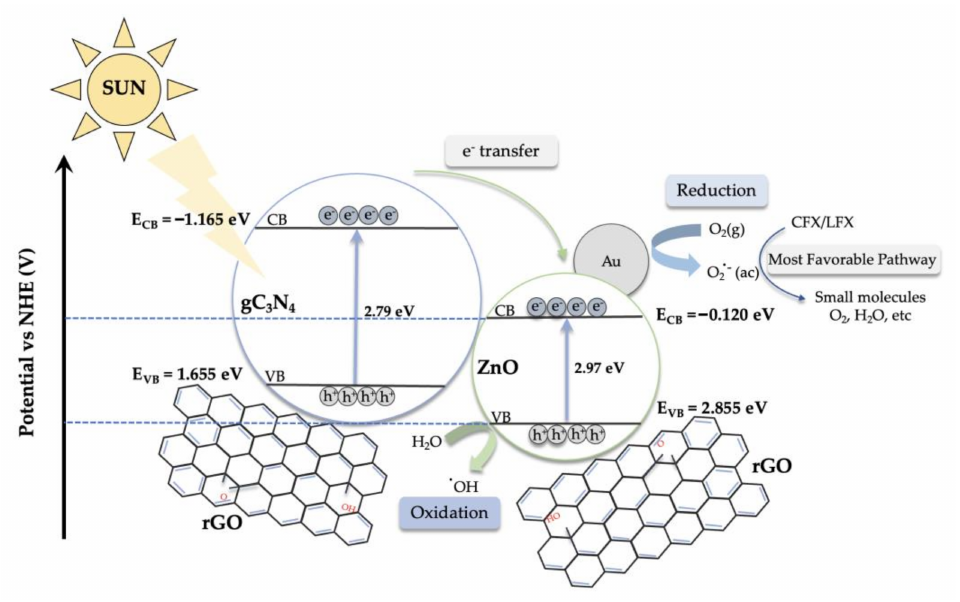
Figure 9. Schematic diagram of the proposed photodegradation mechanism of CFX and LFX under visible